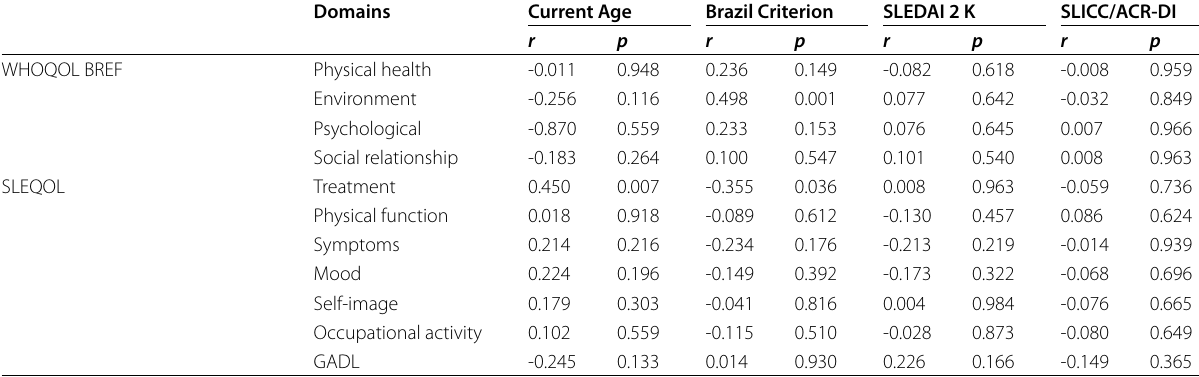
Table 4 Correlations between health-related quality of life scores and clinical and demographic characteristics (N =